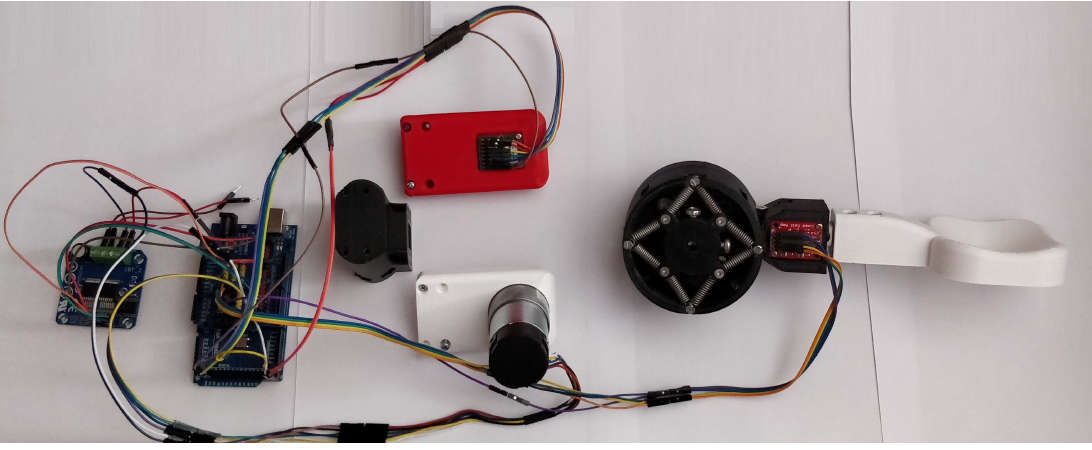
Figure 5. Real test